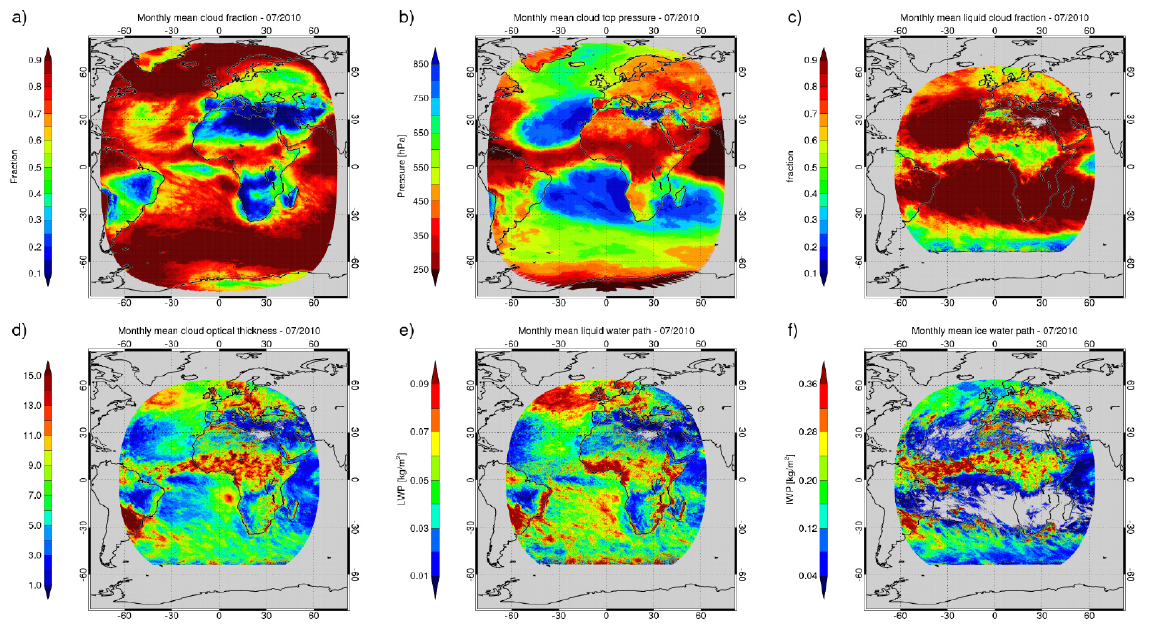
Fig. 3. Examples of monthly averaged CLAAS products for (a) cloud fraction (CFC), (b) cloud top pressure (CTP), (c) liquid cloud fraction (CPh), (d) cloud optical thickness (COT), (e) liquid water path (LWP) and (f) ice water path (IWP). As for the pixel-based products, the optical properties REF and COT (and therefrom derived products CPh, LWP and IWP) are restricted to satellite zenith angles smaller than 72 ◦ . All averaged products stand for in-cloud averages. Together with the histograms the averaged products are defined on a latitude–longitude grid with a grid box size of 0.05 ◦ . All data are for July